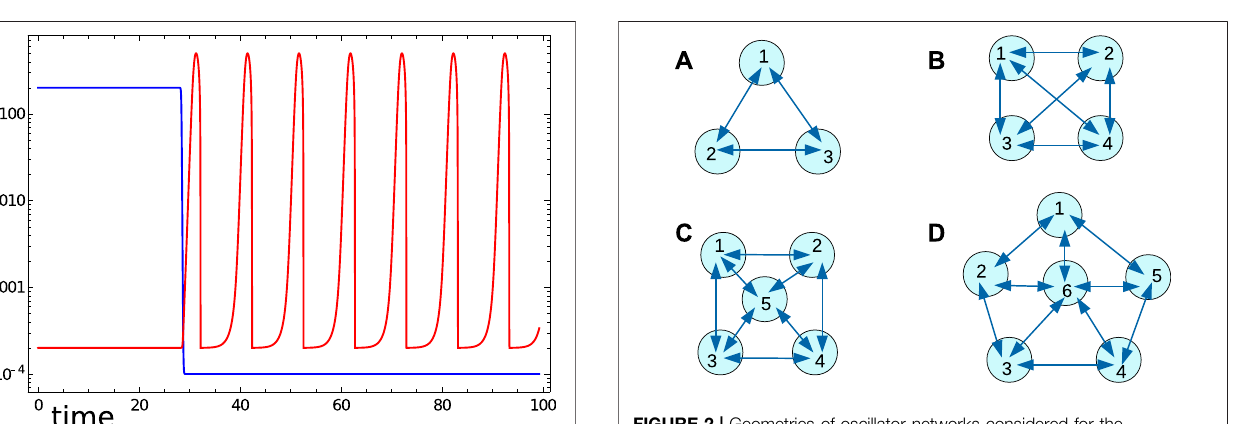
FIGURE 2 | Geometries of oscillator networks considered for the schizophreniadiagnosis.Thedisksrepresentindividualoscillatorsthatcanact as input oscillators or normal ones. Arrows show interactions among the oscillators. The numbers are used to mark individual oscillators in the following description of results. (A) 3-oscillator network, (B) 4-oscillator network, (C) 5-oscillator network, (D) 6-oscillator